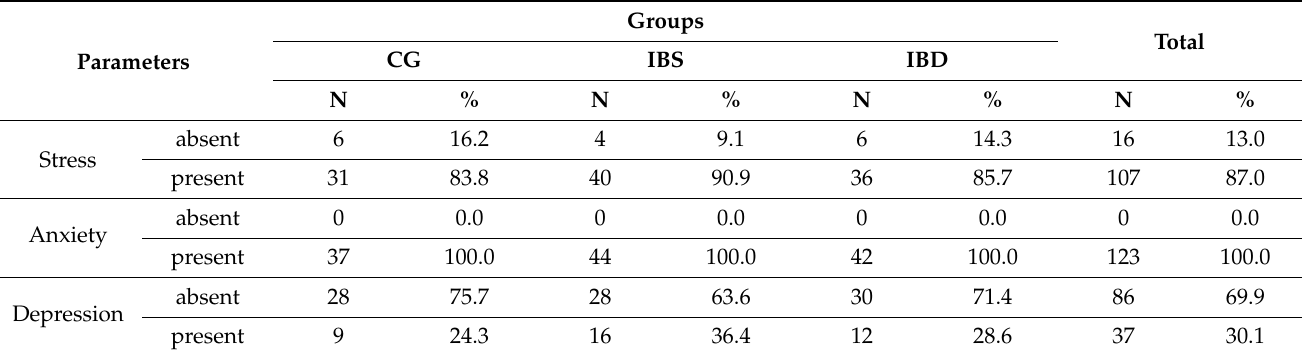
Table 5. Psychological risk factors.